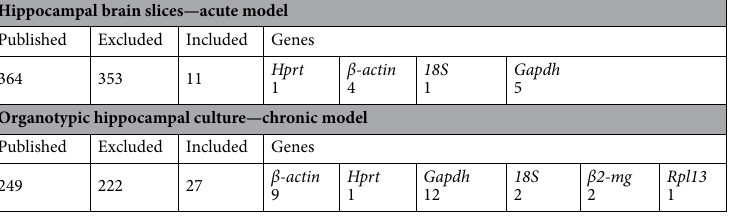
Table 1. Normalization genes used for in vitro gene expression determination in brain ischemia